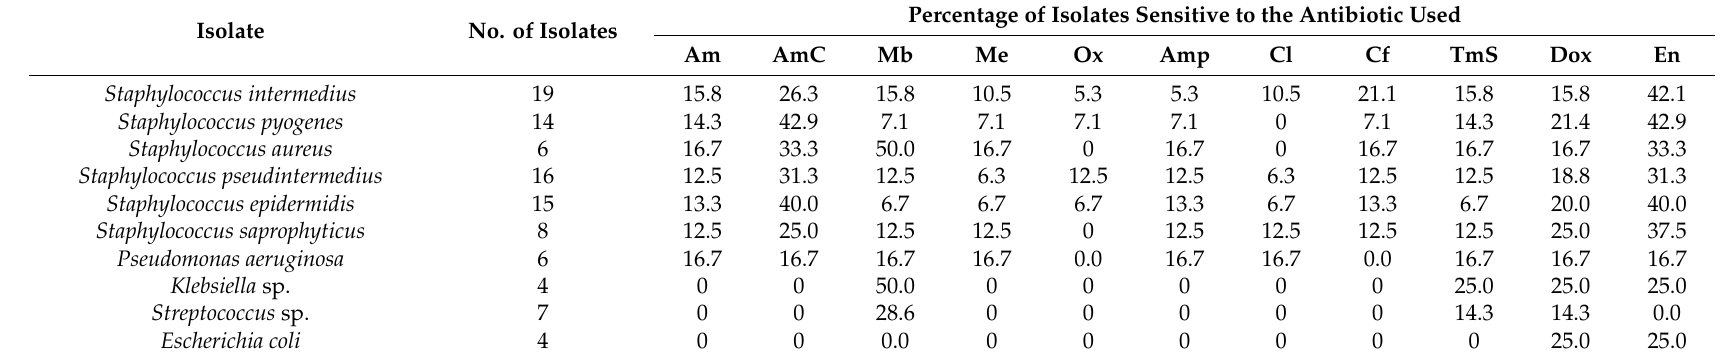
Table 5. In vitro antibiotic sensitivity test of 46 isolates recovered from dogs a ff ected by unresponsive deep canine pyoderma. Percentage of Isolates Sensitive to the Antibiotic Used Isolate No. of Isolates Am En